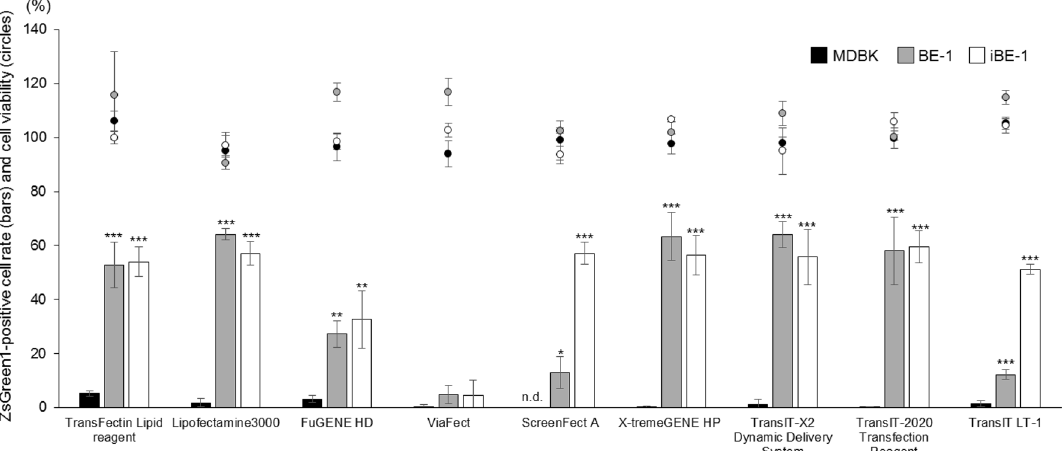
Figure 7. Comparison of transfection efficiencies using various lipofection reagents in BE-1 and iBE-1 cells. The ZsGreen1-expression vector (250 ng/well) was transfected into MDBK cells at P.135, BE-1 cells at P.20 ‒ 24 and iBE-1 cells at P.9–5 ‒ 7, using nine lipofection reagents. The ZsGreen1-positive cell rate (bars) and cell viability (circles) were measured at 48 hpt. ‘n.d.’ means ‘not detected’. Asterisks indicate significant differences from the efficiency of MDBK cells in each lipofection reagent (*** P < 0.001, ** P < 0.01, *P <